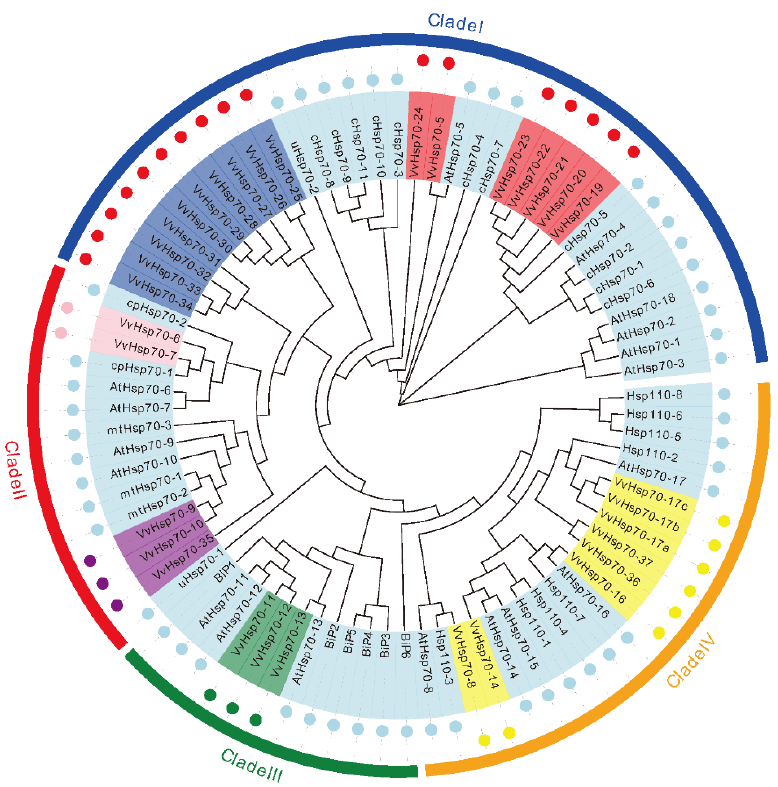
Figure 1. Phylogenetic analysis of VvHsp70 proteins with Arabidopsis and rice. Phylogenetic tree of Hsp70 was generated using ClustalW in MEGA based on Hsp70 amino acids of grape, Arabidopsis , and rice. Clades I–IV stand for the subfamilies I to IV.